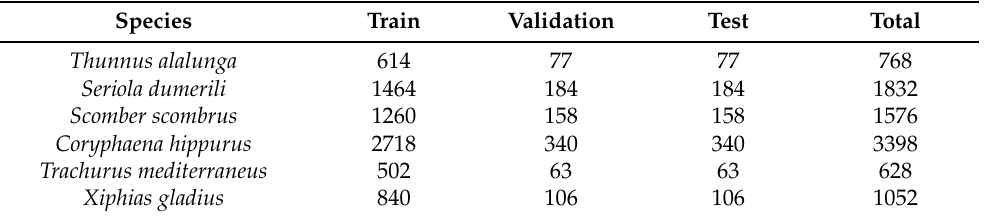
Table 7. Split of the Symbiosis-NCC dataset used for the Multi-class–Mix classification of Table 8. Segments from the same video could be placed in several sets of train, validation and